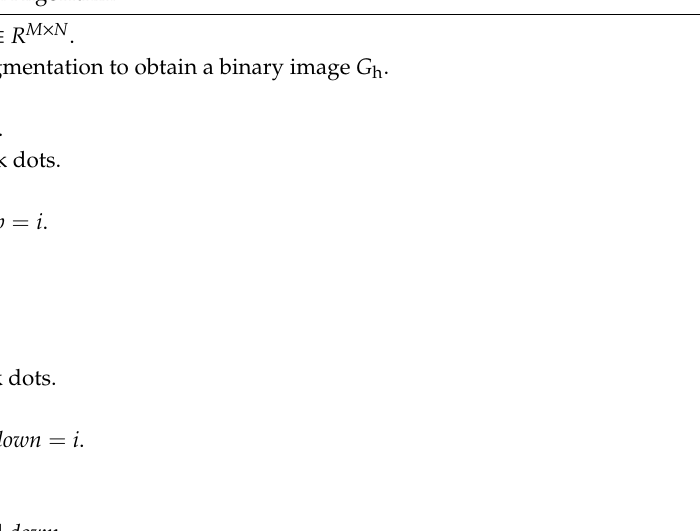
Figure 9. ( a – f ) Torus gray binary images.